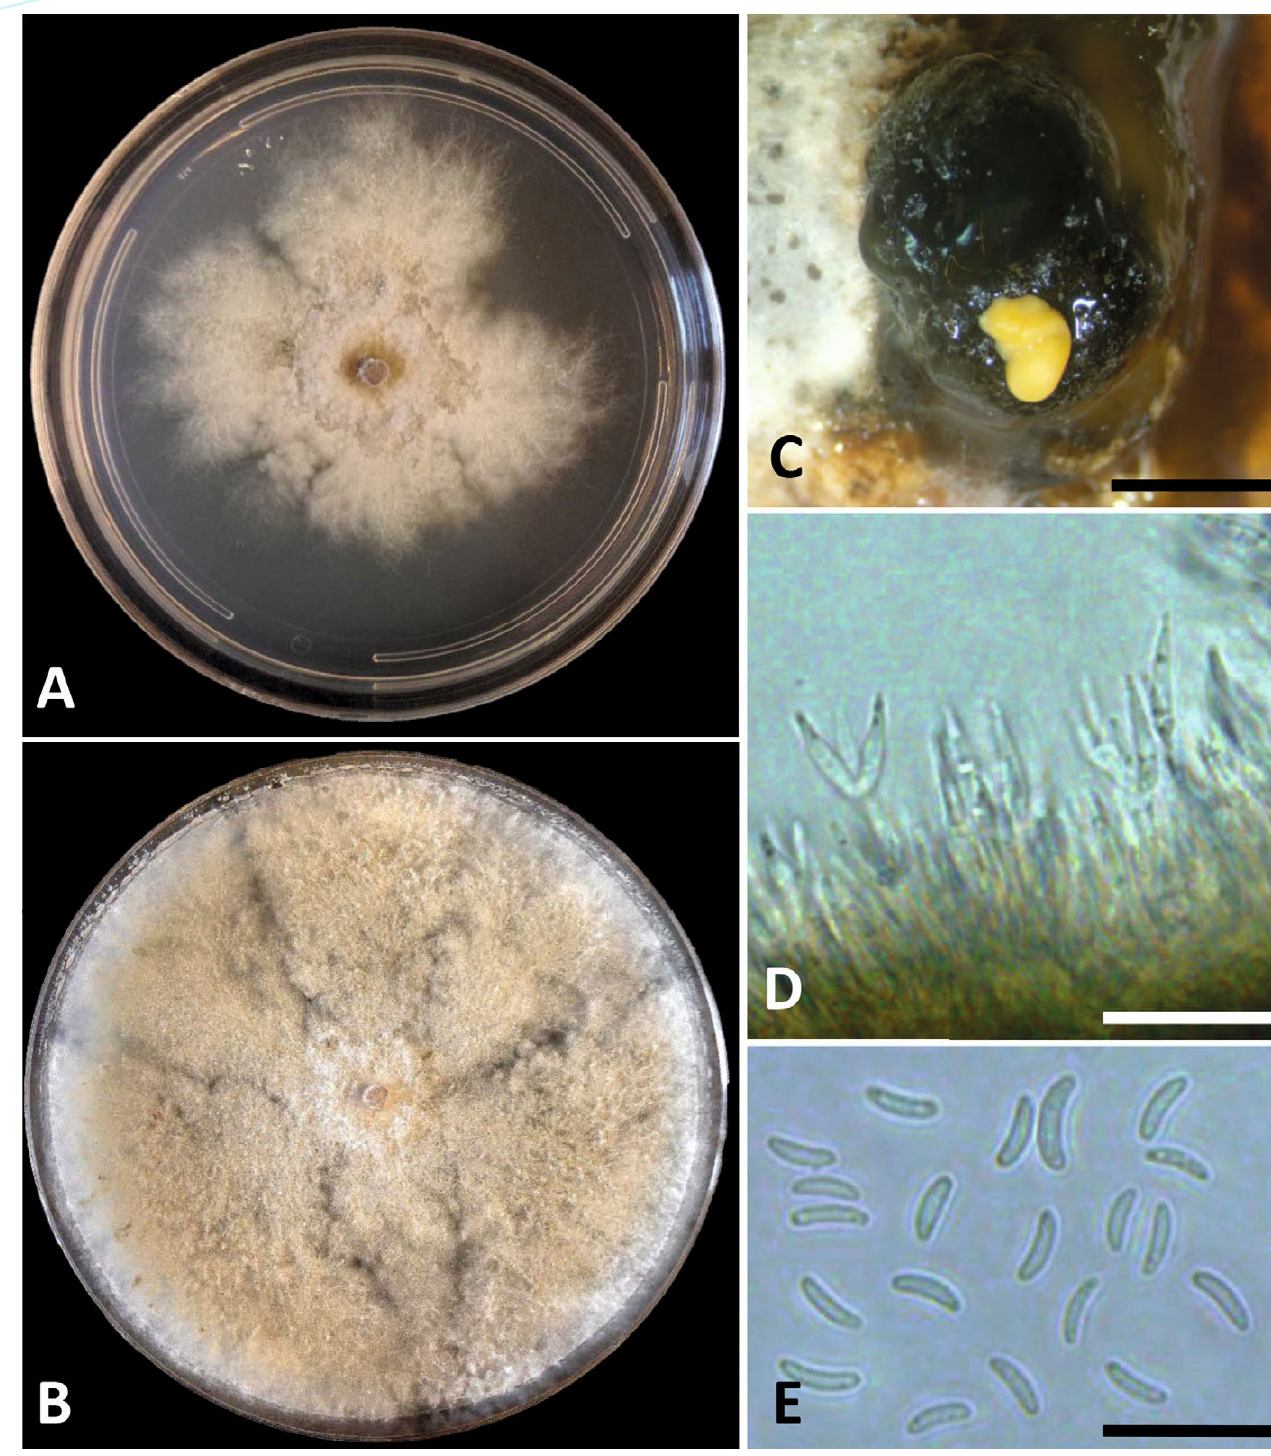
Fig. 17. Cytospora populicola (ex-holotype culture CBS 144240). A. Seven-day-old PDA culture. B. Fourteen-day-old PDA culture. C. Pycnidia. D. (cid:2){(cid:4)(cid:17)(cid:11)(cid:21)(cid:11)(cid:4)(cid:18)(cid:14)(cid:4)(cid:10)(cid:13)(cid:7)(cid:2)(cid:9)(cid:17)(cid:21)(cid:2)(cid:20)(cid:23)(cid:9)(cid:6)(cid:13)(cid:17)(cid:8)(cid:4)(cid:5)(cid:7)(cid:2)(cid:19)(cid:4)(cid:17)(cid:11)(cid:21)(cid:11)(cid:4)(cid:25)(cid:13)(cid:17)(cid:4)(cid:5)(cid:7)(cid:2)(cid:19)(cid:13)(cid:23)(cid:23)(cid:7)(cid:28)(cid:2) E. Conidia. Bars C = 500 μm; D–E = 10